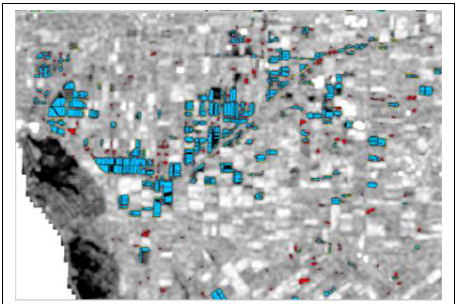
Figure 5. A closer view of an inundated agricultural area. TP pixels are presented with cyan colour, FP with red and FN with yellow colour.